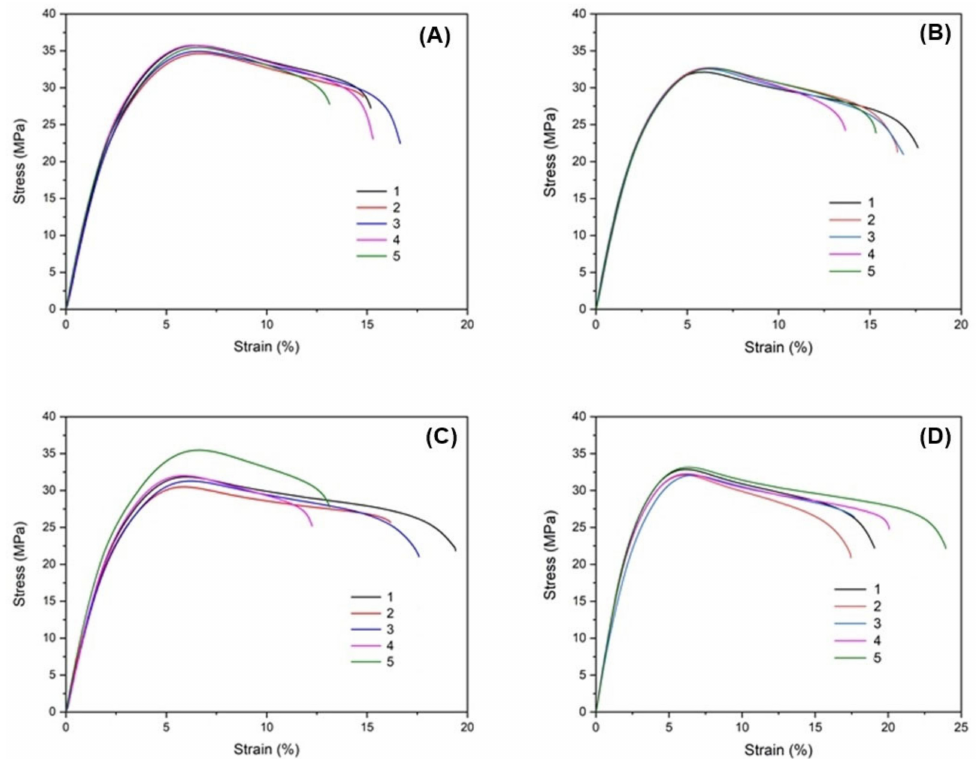
Figure 3. Tensile stress-strain curves of vPP/rPP blended with different rPP concentrations. ( A ) vPP,